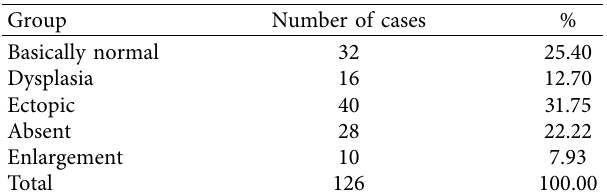
Table 1: Morphological changes of the thyroid gland in 126 children with